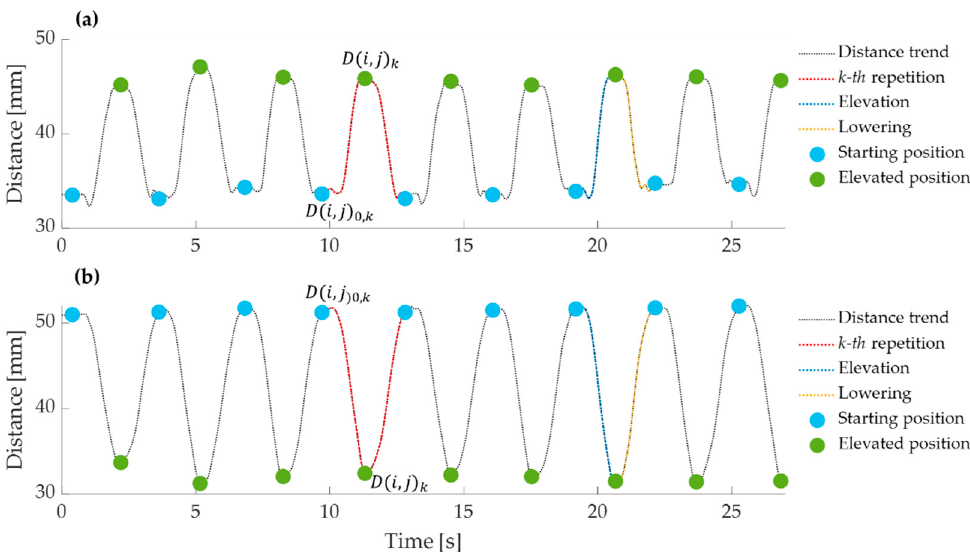
Figure 5. Two examples of distance trend (in black) between pairs of markers collected on a volunteer during a trial. The ten repetitions are visible. The distance during a k − th repetition is highlighted in red, during an elevation phase in blue, and during a lowering phase in yellow. The events corresponding to the starting and elevated positions are highlighted by light blue and green circles, respectively. ( a ) Example of distance increasing during the elevation phase (in blue) and decreasing during lowering (in yellow), which means a skin extension, and ( b ) example of distance decreasing during the elevation phase (in blue) and increasing during the lowering (in yellow) which means a skin compression.